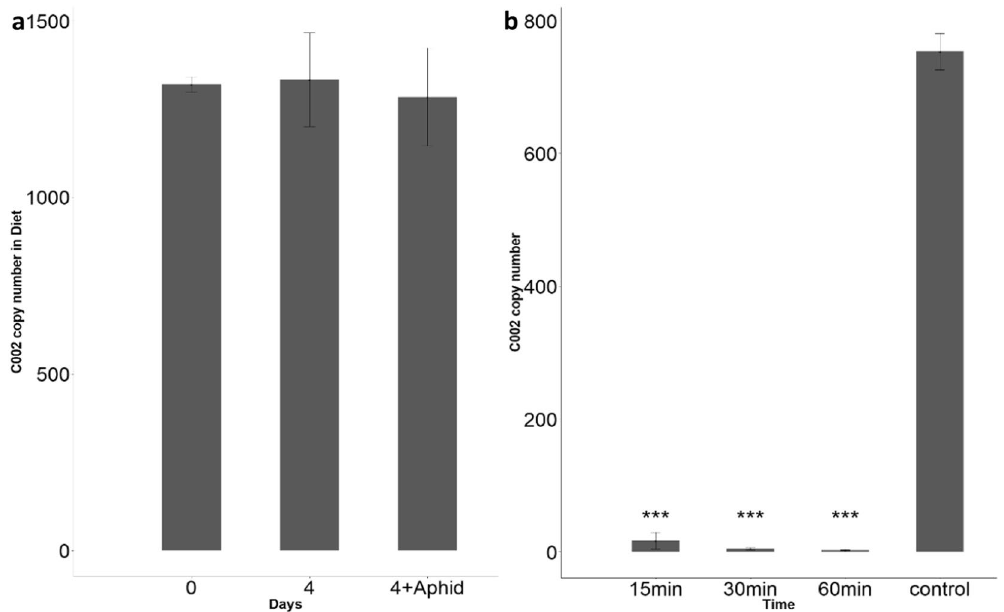
Figure 5. dsRNase transcripts are abundant in aphid midguts, and dsRNase activity is high in midgut extracts. ( a ) Digital PCR showing that commercially synthesized Mp_C002_dsRNA levels in artificial diet remain high after four days even if aphids are allowed to feed on the diet suggesting saliva is not degrading the dsRNA quickly (‘4 + adults’; ANOVA, replicates = 3, p = 0.41). ( b ) Digital PCR showing that commercially synthesized Mp_C002_dsRNA is rapidly degraded if incubated with aphid midguts (ANOVA, p = 0.0001, replicates = 3). The control contained dsRNA without midgut – results shown after 1 hr. Asterisks shows significant change in MP_C002_dsRNA